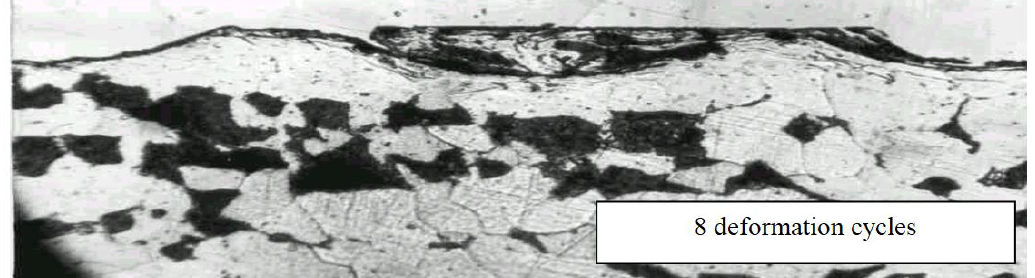
Fig. 7. The nature of the deformation of the microprotrusion of a workpiece made of steel 45 with the number of deformation cycles equal to 8; 